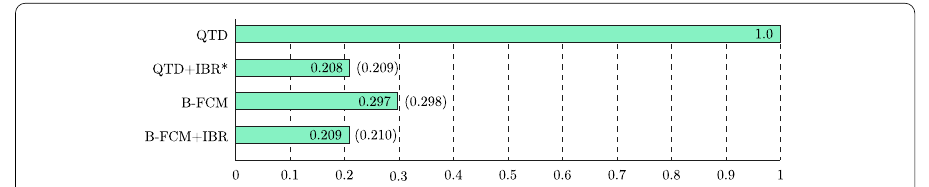
Fig. 32 Time compression ratios for the computation of the cell matrices (values inside the bars) and for the entire processing step (values outside the